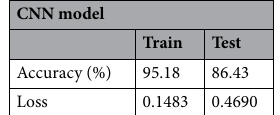
Table 6. CNN model training and validation.